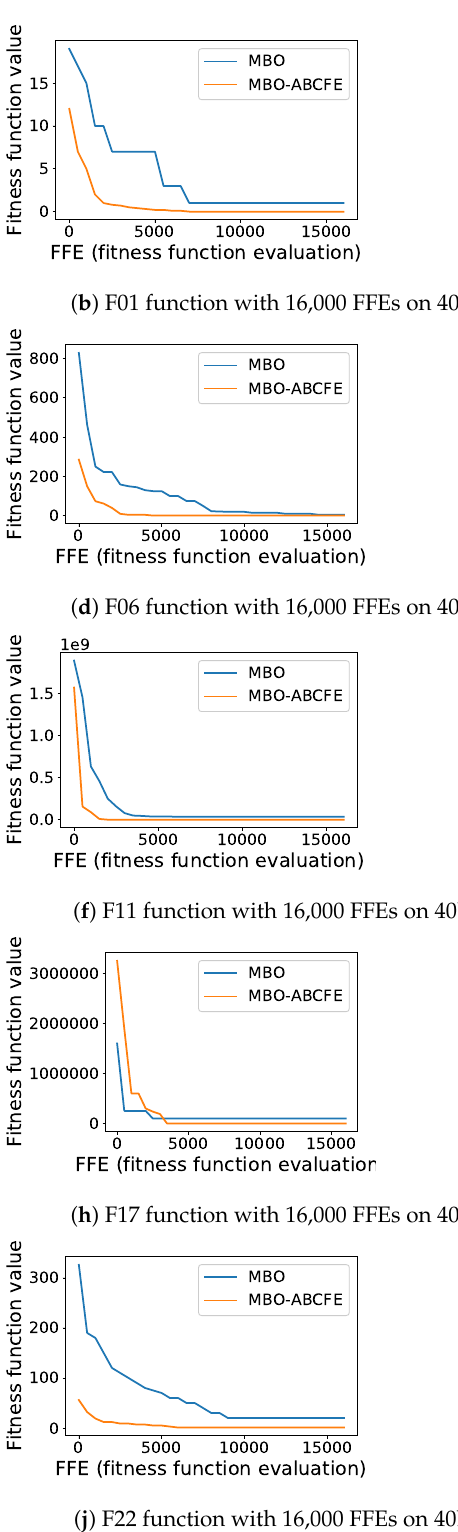
( j ) F22 function with 16,000 FFEs on 40D Figure 3. Convergence graphs. (FFE, fitness function evaluation): ( a ) F01 function with 8000 FFEs on 20D; ( b ) F01 function with 16,000 FFEs on 40D; ( c ) F06 function with 8000 FFEs on 20D; ( d ) F06 function with 16,000 FFEs on 40D; ( e ) F11 function with 8000 FFEs on 20D; ( f ) F11 function with 16,000 FFEs on 40D; ( g ) F17 function with 8000 FFEs on 20D; ( h ) F17 function with 16,000 FFEs on 40D; ( i ) F22 function with 8000 FFEs on 20D;